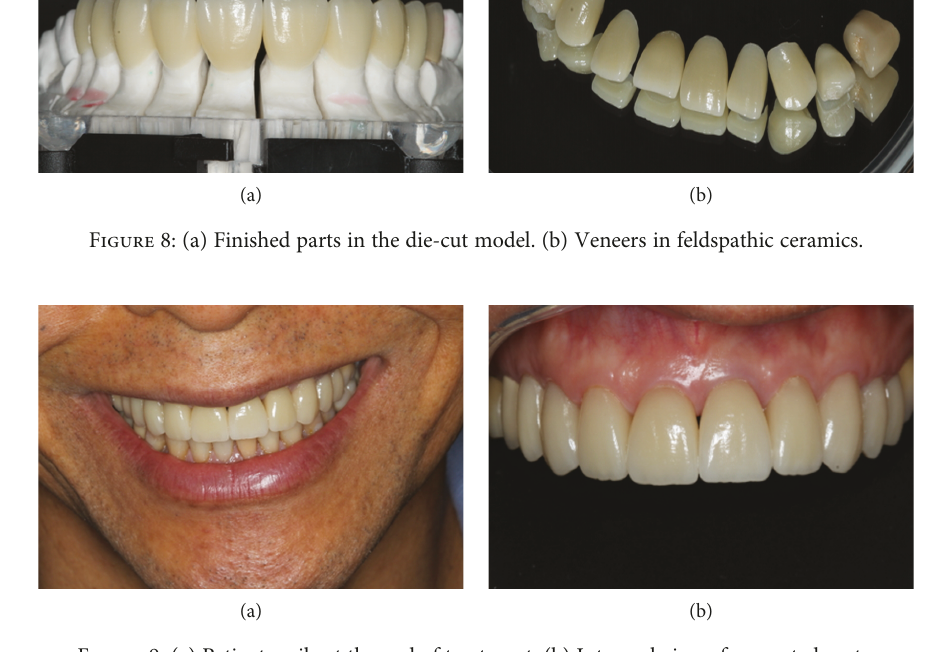
Figure 9: (a) Patient smile at the end of treatment. (b) Intraoral view of cemented